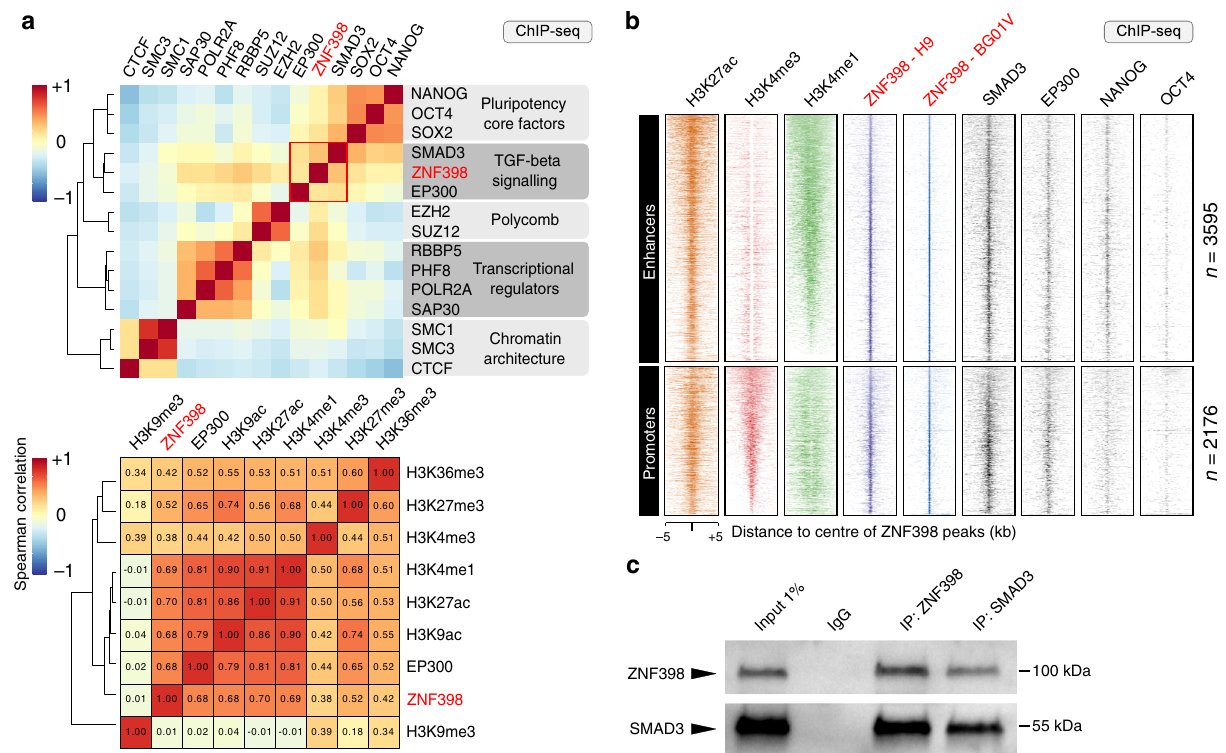
Fig. 6 ZNF398 activates transcription in concert with SMAD3 and EP300. a Top: Hierarchical clustering of 15 genome-wide-binding pro fi les (available genome-wide binding pro fi les from CODEX 45 ). Normalised Pointwise Mutual Information (NPMI) between each pair of samples were used to display all pairwise binding overlaps in a clustered heatmap 45 . Colours in the heatmap show the level of overlap for each pair of samples (red, all binding sites overlapped; yellow, overlap expected by chance; blue, mutually exclusive binding). Bottom: Hierarchical clustering of pairwise Spearman correlation of ZNF398 and ChIP-seq datasets indicated. Colours indicate the level of correlation (red indicates perfect correlation, blue indicates perfect anticorrelation). ZNF398 clusters together with active histone marks. See also Supplementary Fig. 6a for DNA motifs associated with ZNF398 peaks. b Binding plots show the location of ZNF398 (obtained in two hPSC lines, H9 and BG0V1) and H3K27ac, H3K4me3, H3K4me1, SMAD3, EP300, NANOG and OCT4. 5771 sites are displayed within a 10kb window centred around ZNF398 peaks. Note the presence of ZNF398 both at active enhancers (H3K4me1 positive) and active promoters (H3K4me3 positive). c SMAD3 interacts with ZNF398. Co-IP with antibodies against SMAD3, Avi-Tag-ZNF398 and IgG were performed on nuclear lysates of H9 expressing ZNF398, treated with 25ng/ml Activin A for 1h to promote nuclear accumulation of SMAD3. Precipitated complexes were probed for endogenous SMAD3 and Avi-Tag-ZNF398. Representative of two independent experiments. Uncropped gels are provided as a Source Data fi